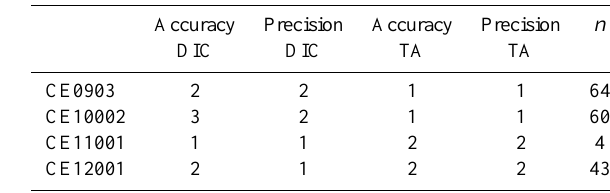
Table 3. Accuracy and precision of DIC and TA in µ molkg − 1 for each of the surveys, calculated as the average and standard devi- ation, respectively of the di ff erences between duplicate samples, where n is the number of duplicate